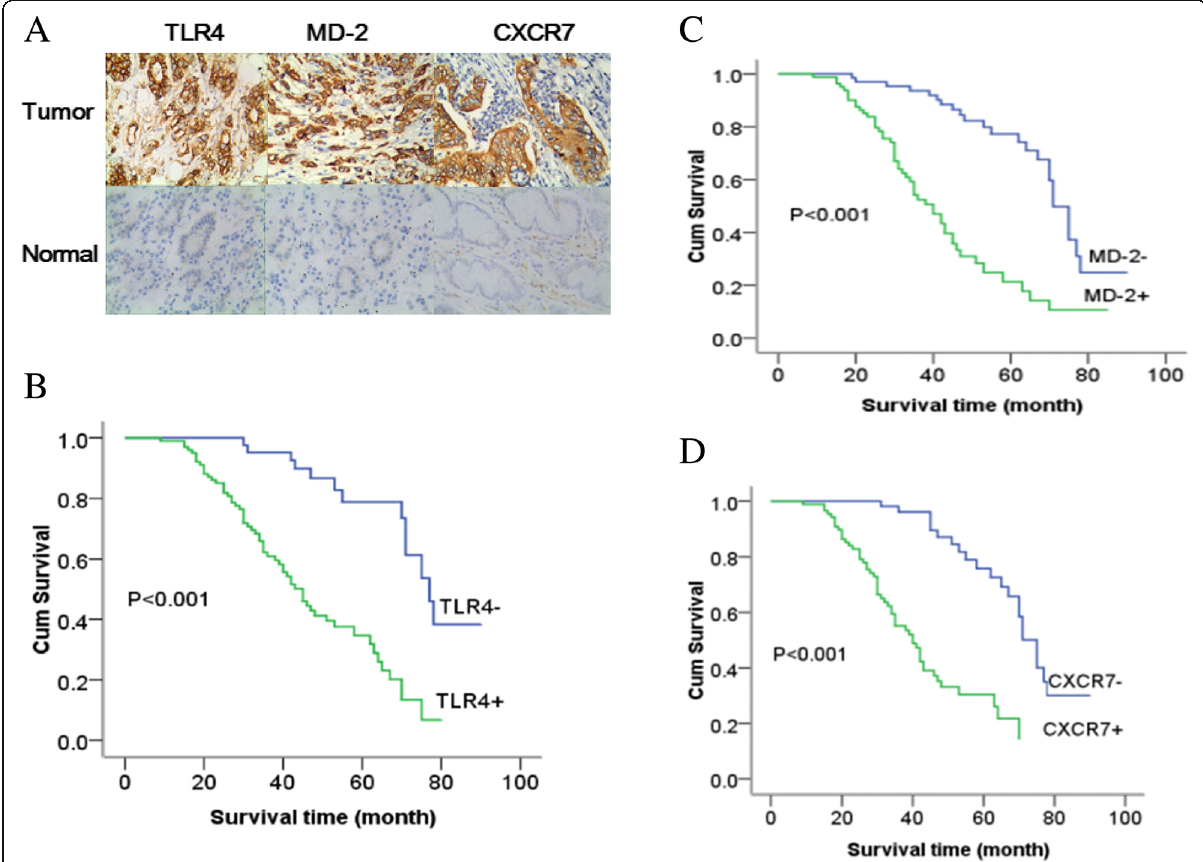
Fig. 4 TLR4, MD-2 and CXCR7 expression in gastric cancer indicates poor prognosis. a : Representative immunohistochemical staining of TLR4, MD-2 and CXCR7 in gastric cancer tissues and paracancerous tissues (original magnification 400×); survival curve for patients with gastric cancer expressing TLR4 ( b ), MD-2 ( c ) and CXCR7 ( d